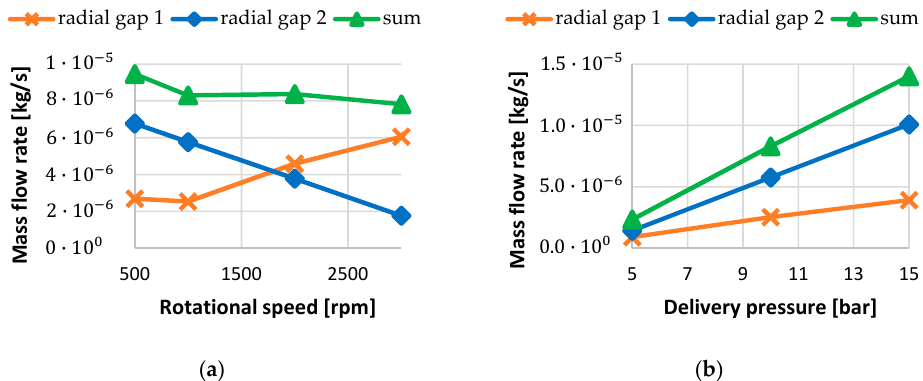
Figure 14. Leakage mass flows through the radial gaps under ( a ) variation of the rotational speed at a delivery pressure of 10 bars ( b ) variation of the delivery pressure at a rotational speed of 1000 rpm.